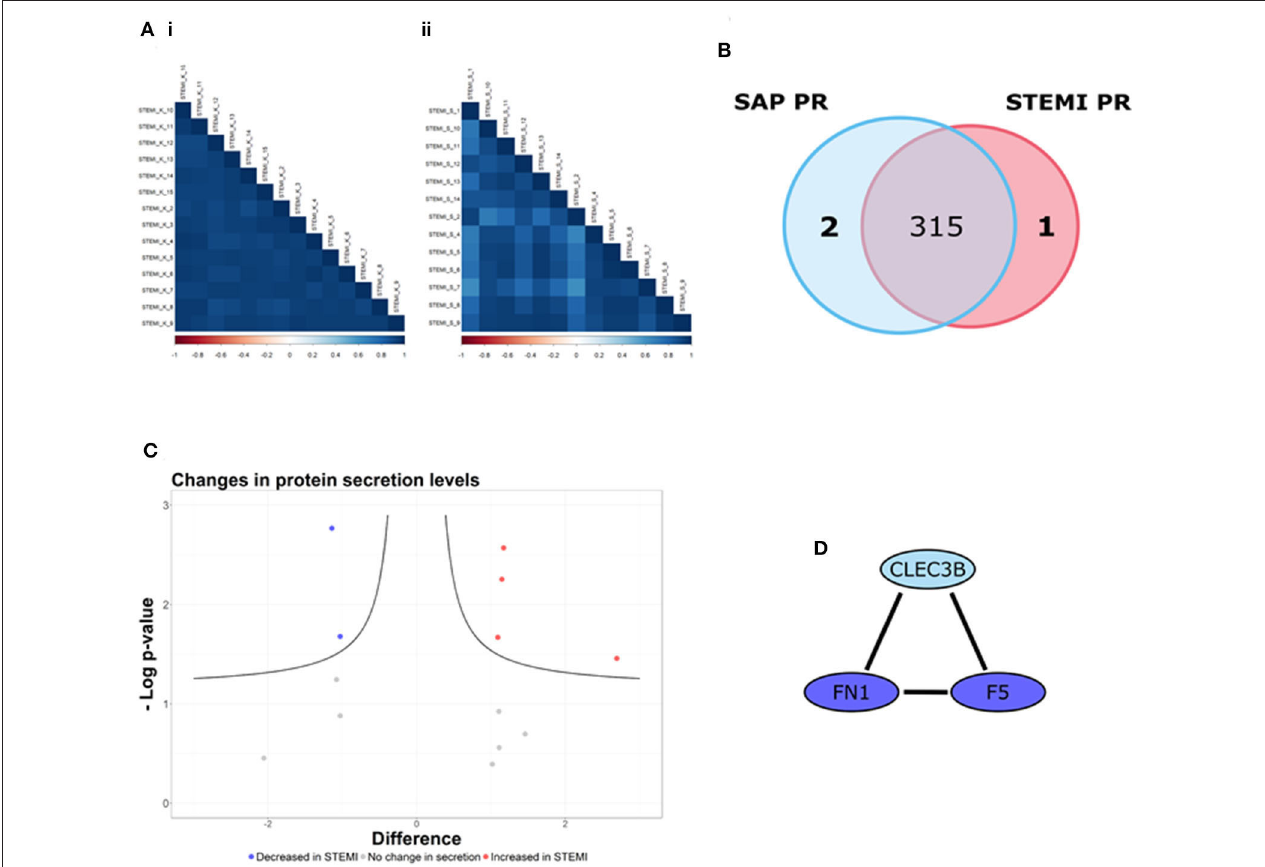
FIGURE 2 | The PR is different between STEMI and SAP. (A) Strong inter-patient correlations ( r > 0.88) were found in the 13 STEMI and 14 SAP platelet releasate (PR) samples. (B) 318 PR proteins were identified (in at least 50% of samples in at least one patient cohort), including one PR protein unique to STEMI (red) and two PR proteins unique to SAP (blue). (C) Volcano plot of STEMI vs. SAP PR proteomes (x-axis representing the difference between the mean log2 LFQ values of STEMI to SAP PR; y-axis, the negative log transformed p -value) representing the proteins significantly altered in each condition. The black hyperbolic curved lines show the threshold for statistical significance, where a false discovery rate of 0.05 and an S 0 (minimal difference between the mean log2 LFQ values) of 0.1 was used. Of the 14 proteins used for statistical comparison (difference between the mean log2 LFQ values > 1/1), our analysis revealed that the secretion levels of 4 proteins were significantly increased in STEMI PR (red dots) whereas 2 proteins were significantly decreased in STEMI PR (blue dots). The secretion levels of the remaining 8 proteins were unchanged (gray dots). (D) The STRING database (http://string-db.org/; version 10.5) was used to allocate protein interactions utilizing experimental and database sources. An interaction network of high confidence ( > / = 0.700 denoted by line thickness) consisting of three proteins (F5; FN1; CLEC3B) was